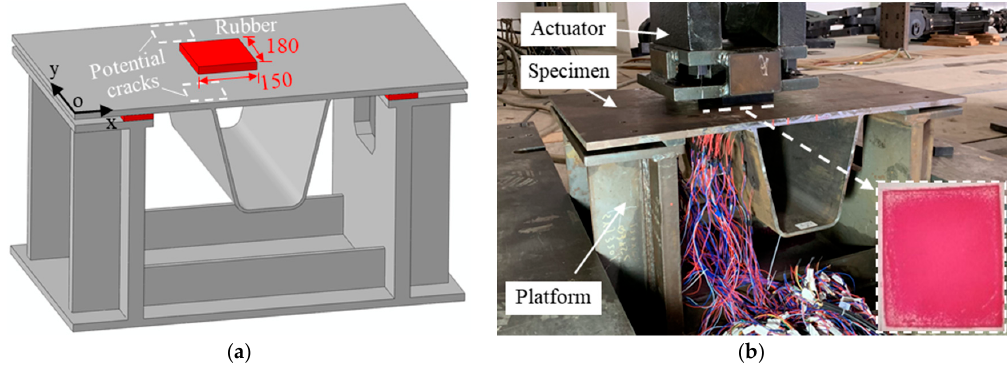
Figure 3. Test setup: ( a ) schematic view and ( b ) photography.